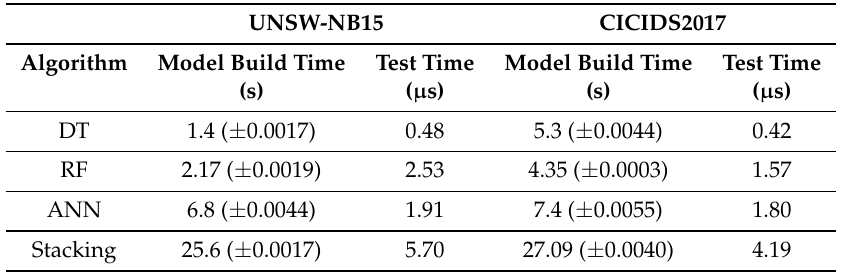
Table 11. Mean model building time and per sample test time for the base and Stacking classifier on UNSW-BC15 and CICIDS2017 datasets. The value within the bracket indicates the standard deviation among ten